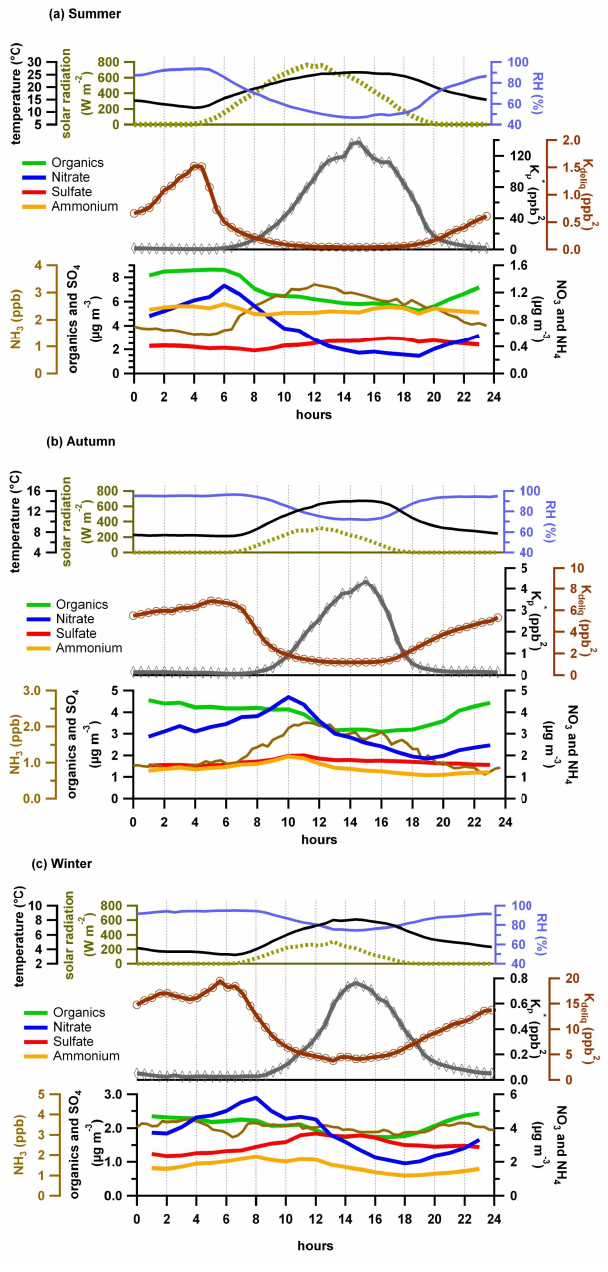
Fig. 7. Diurnal variations of the nitrate concentration and its ther- modynamic constants for (a) summer, (b) autumn and (c)